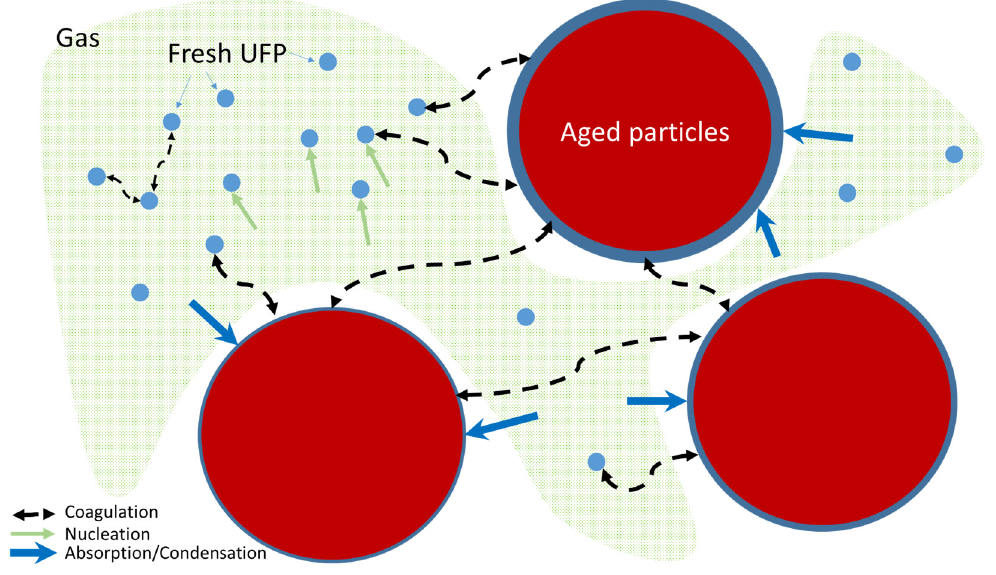
Figure 10. Physical processes at work during the dilution in the presence of pre-existing aged particles.